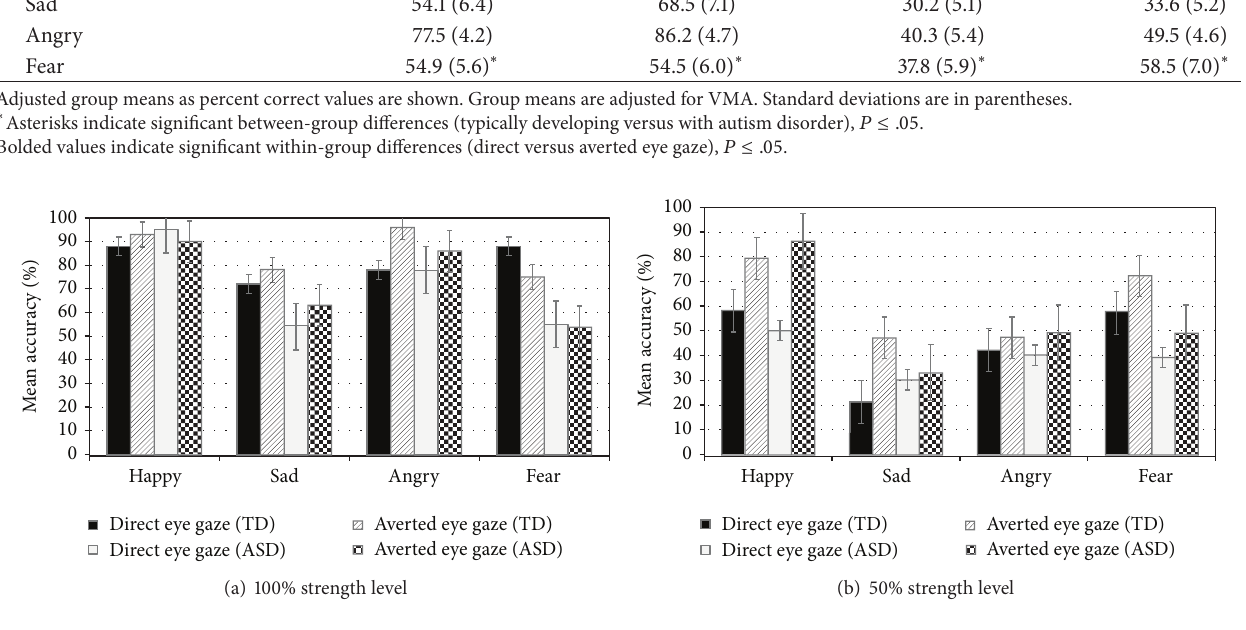
Figure 2: Mean percent accuracy scores for the effects of eye gaze direction on recognition of facial expressions at 100% and 50% expression strengths for children with autism disorder and typically developing